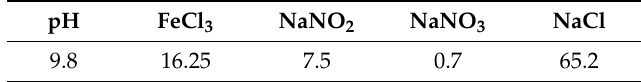
Table 2. Chemical composition of the simulated district heating water